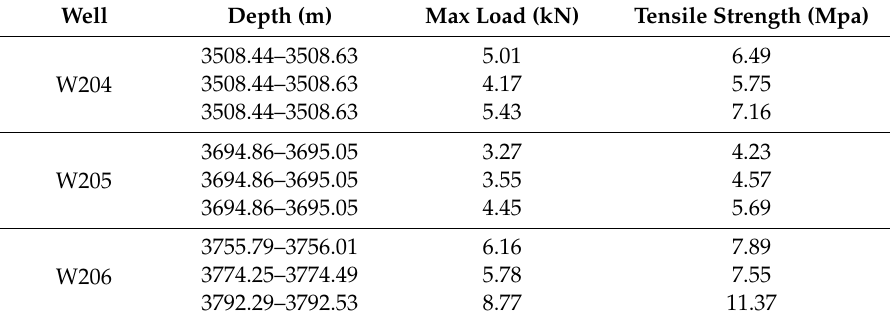
Table 2. Brazilian test results of Longmaxi Formation, in W204, W205, W206. Well Depth (m) Max Load (kN) Tensile Strength (Mpa) W204